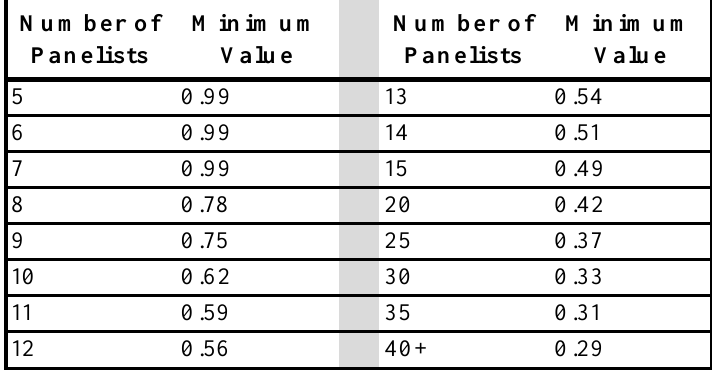
CVR value of each